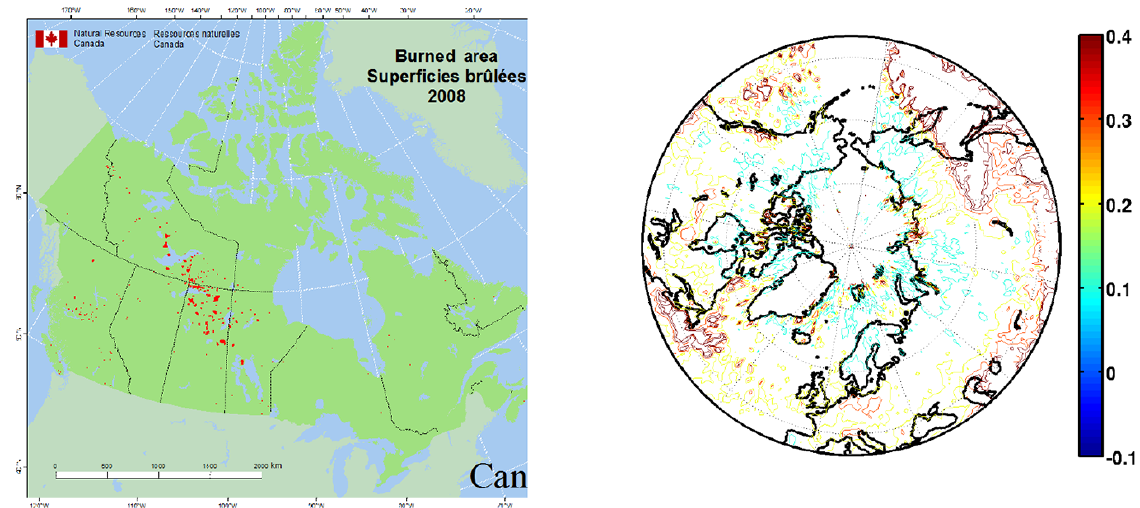
Figure 11. Map of the Canadian Forest Service fire counts in red for summer 2008 (left) and MODIS aerosol optical depth at 0.55µm from 15 June to 15 July 2008 (right).